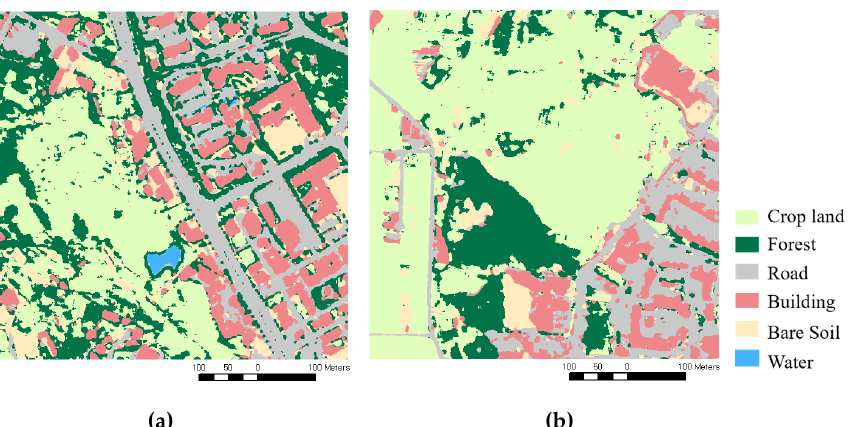
Figure 8. Classification results of hyperspectral UAV images at the two South Korea sites: ( a ) Site 1, ( b ) Site 2. Table 2. Classification results of the South Korean sites: F1 score and overall accuracy. F1 Score OA (%) Crop Land Forest Road Building Water Bare Soil